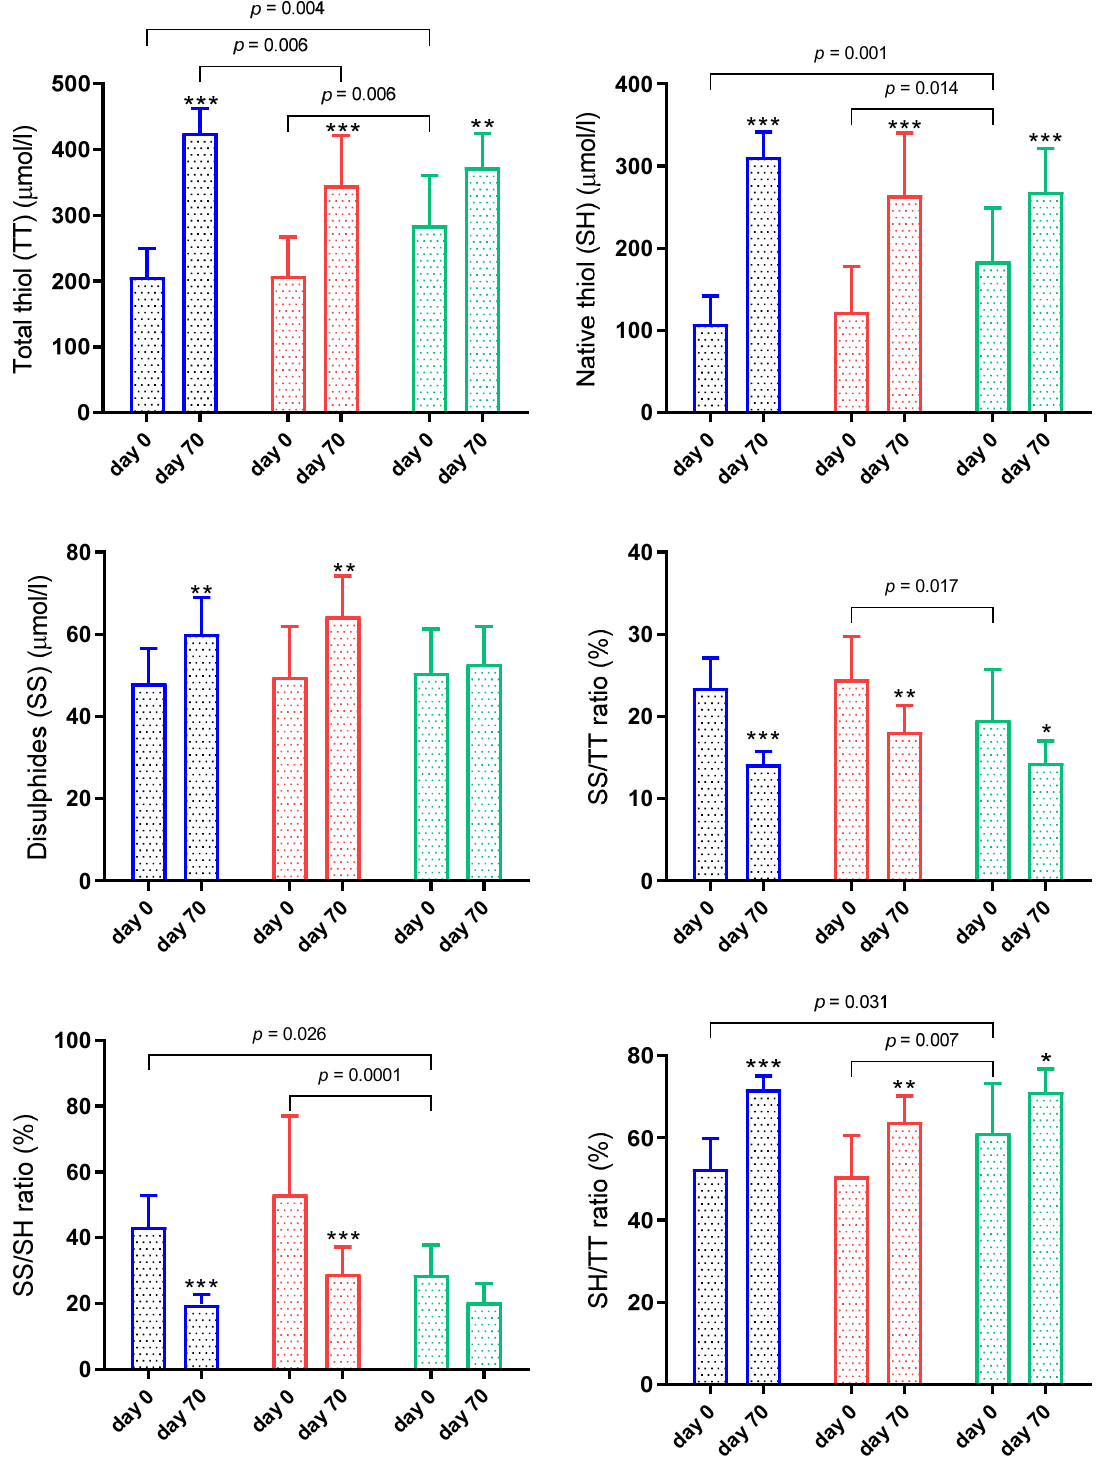
Figure 2. Results for thiol-disulphide homeostasis in sheep naturally infected by gastrointestinal nematodes. G1 (blue bar): faecal worm egg counts (EPG) higher than 5000 and packed cell volume (PCV) lower than 24%; G2 (red bar): EPG higher than 5000 and PCV higher than 24%; G3 (green bar): EPG lower than 5000 and PCV higher than 24%. Asterisks indicate significantly different from day 0. * p < 0.05; ** p < 0.01; *** p < 0.001.